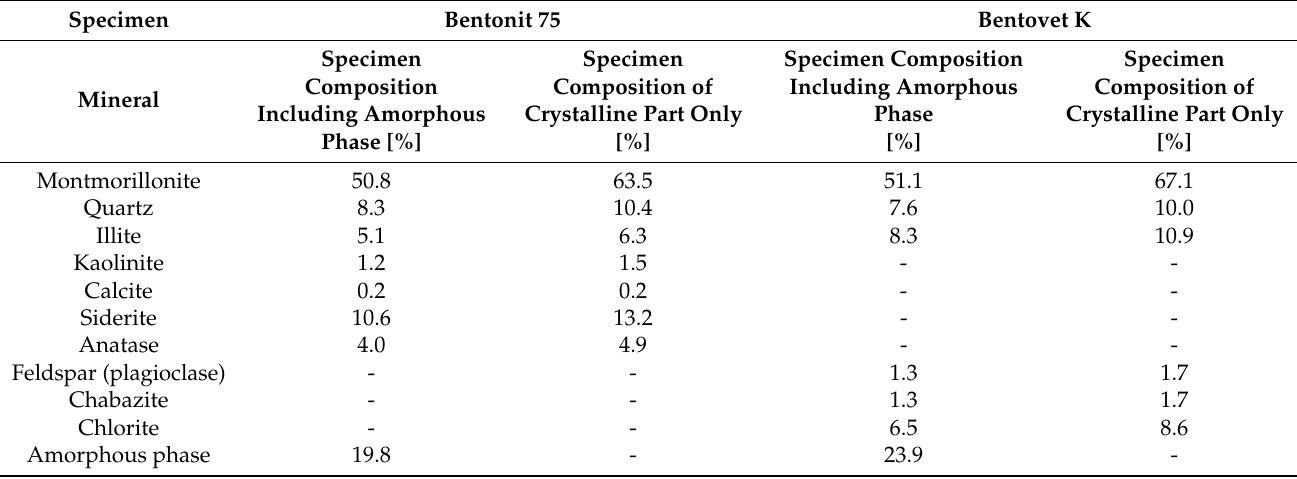
Table 1. Results of quantitative phase